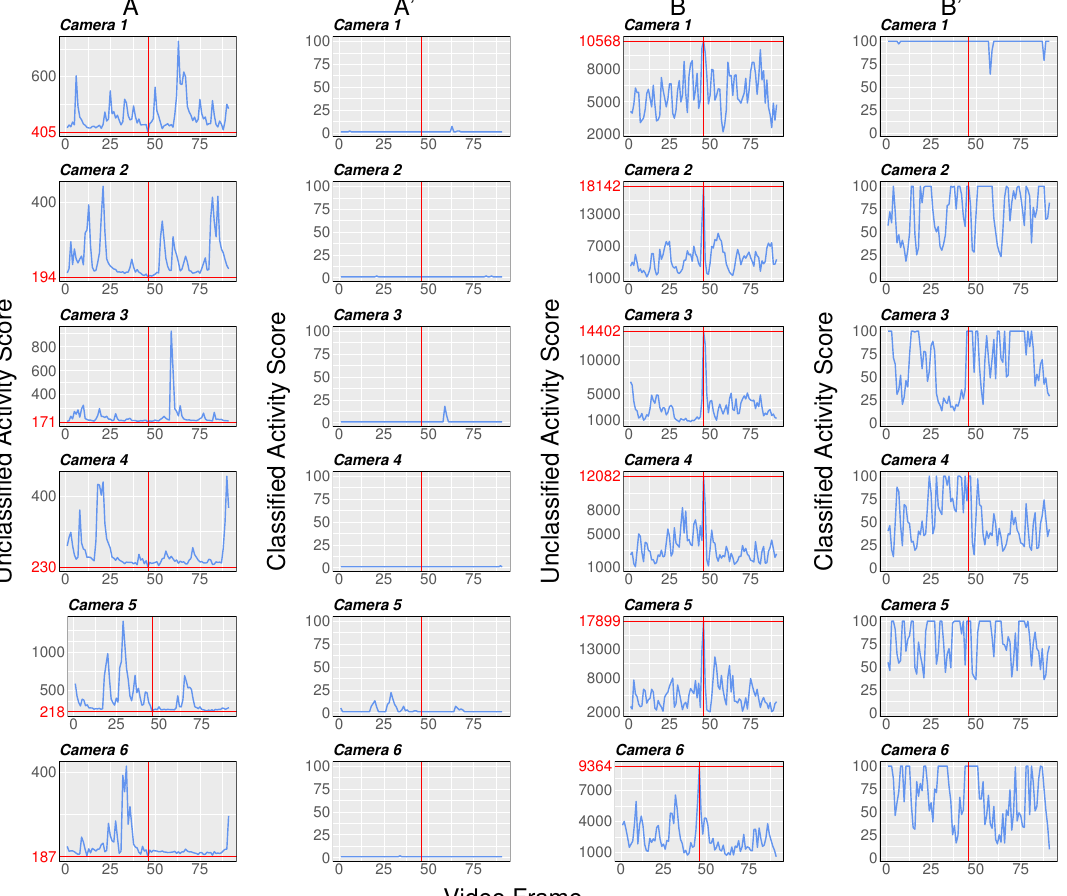
Figure 6. Comparison of unclassified activity scores ( A , B ) and their assignment into activity score classes ( A ’, B ’) for videos of lower ( A ) and higher ( B ) activity intensities. The 90-second sequences are centered around the minimum activity score value for the sequences in ( A ) and maximum activity score value for the sequences in ( B ) indicated by the vertical red